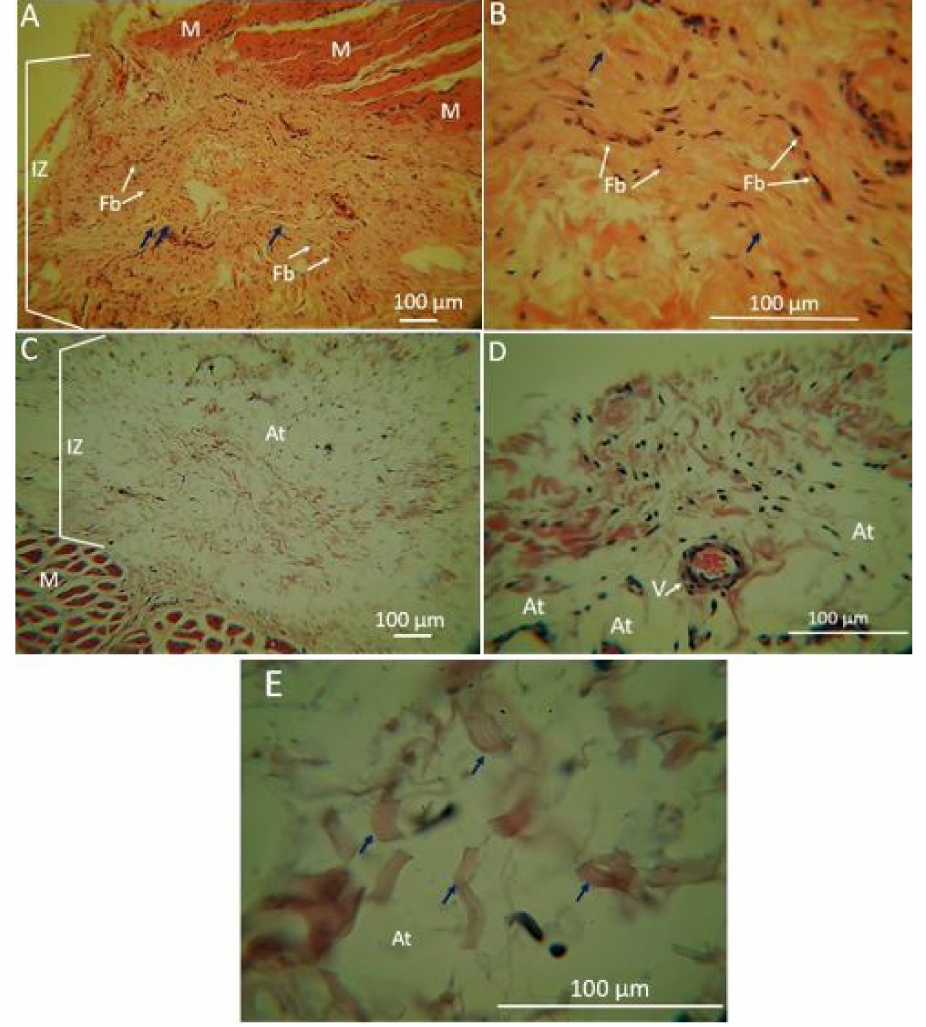
Figure 7. Nanocomposite F1 implanted in the Wistar rat subdermal area at 30 and 90 days. ( A ) at 10 × implantation at 30 days. ( B ) at 40 × implantation at 30 days. ( C ) at 10 × implantation at 90 days. ( D ) at 40 × implantation at 90 days. ( E ) at 100 × , implantation at 90 days. IZ. Implantation area. M: Muscle. Fb: Fibroblasts. At: Adipose tissue. Blue arrow: polymeric fibers (sample). V: Blood vessel. Hematoxylin and Eosin Technique